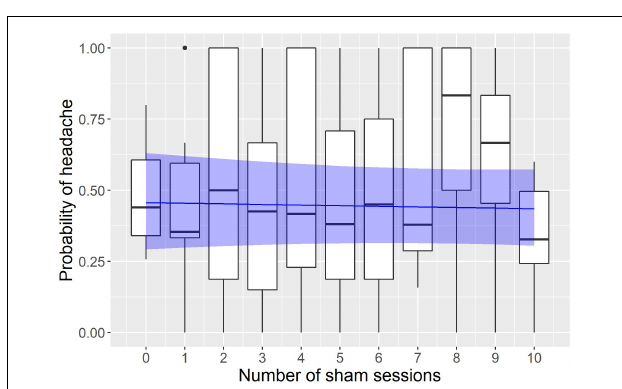
FIGURE 2 | Modeling of the influence of sham sessions on the headache probability. The x axis represents the number of sham sessions the subject had to date; the y axis represents the probability to have a headache on a given day. Observed probabilities are shown by boxplots in black (the lower and upper hinges correspond to the first and third quartiles; the bold horizontal line corresponds to the median; the whiskers extend to the largest value no further than 1.5 inter-quartile range from the hinge; outliers are shown by dots). The probability predicted by the model is indicated by the blue line with a ribbon representing 95% confidence interval.